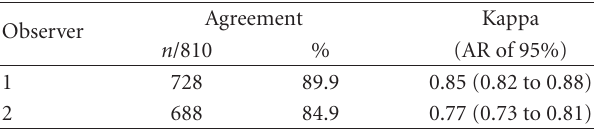
Table 6: Evaluation of intraobserver agreement in the study of loci numbers.